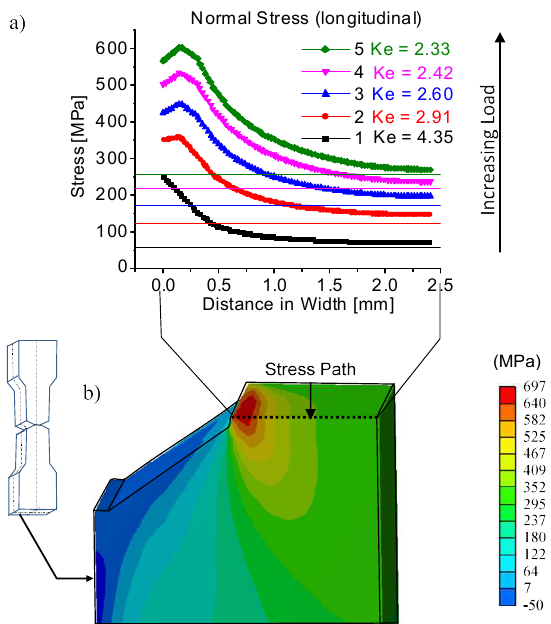
Figure 10. FE-calculated effective stress concentration factors: ( a ) normal stress distribution in the loading direction along a path from the notch root to the center of the specimen as a function of the applied load 1, 2, 3, 4, and 5; ( b ) FE-calculated normal stress field in the vicinity of the notch corresponding to Level 1 of the applied load corresponding to Level 5 of the applied load.